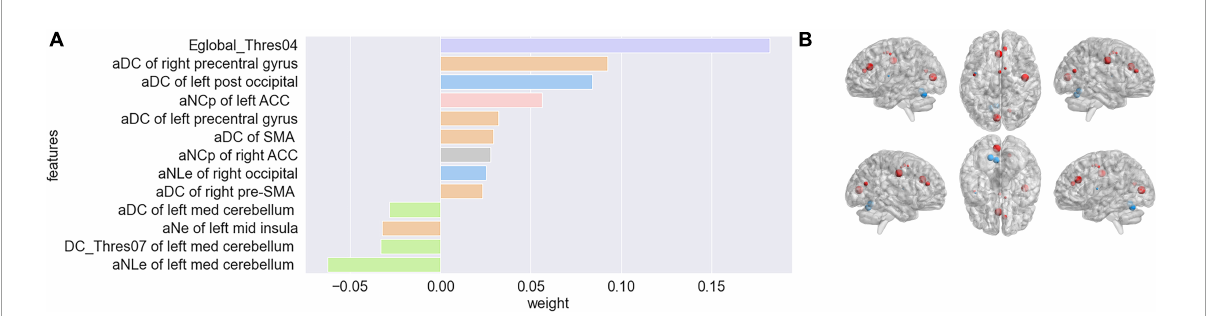
FIGURE2 The top 13 selected features were obtained after the Mann-Whitney U -test and LASSO and the corresponding feature weight (feature weight was arranged from positive to negative) (A) . A represents a threshold-independent selection. NLe, nodal local efficiency; DC, degree centrality; NCp, nodal clustering coefficient; Ne, nodal efficiency. Five different colors represent different subnetworks (green-cerebellum, blue-occipital, pink-cingulo-opercular, orange-sensorimotor, gray-DMN). The brain regions correspond to the 13 features selected by the Mann-Whitney U -test and LASSO and the alterations of topological metrics (B) . Red represents a significantly increased topological metric value in ET compared with HCs and blue represents a significantly decreased topological metric value in ET compared with HCs ( P < 0.01). The larger the ball, the higher the frequency.